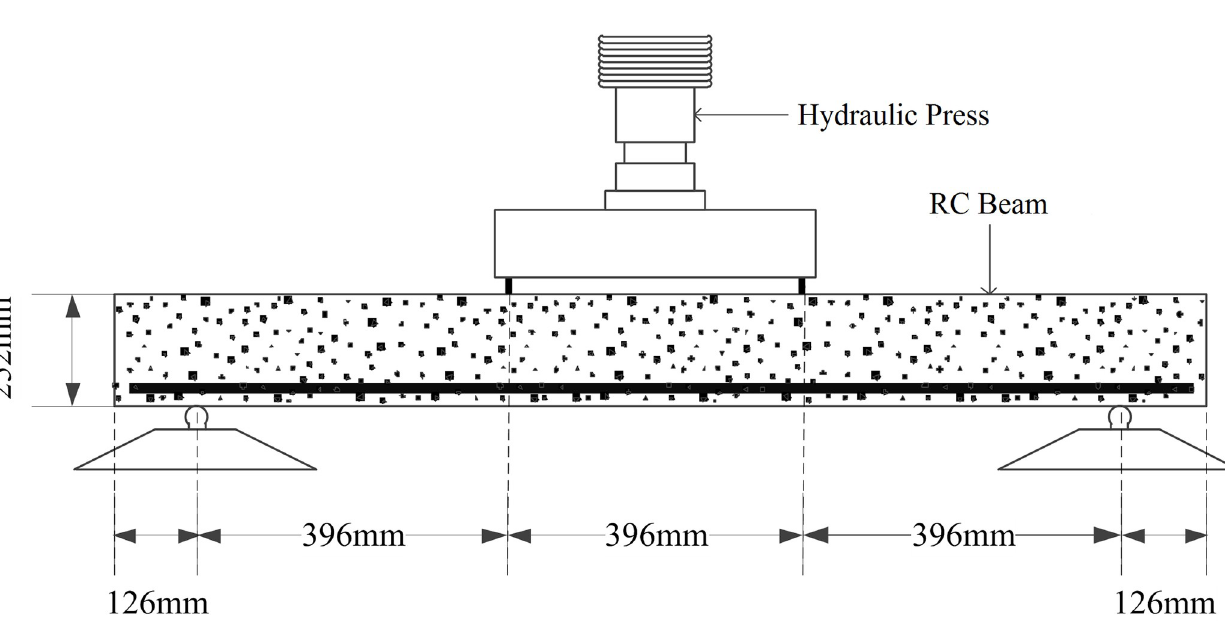
Fig 14. Test device and four points bending RC beam